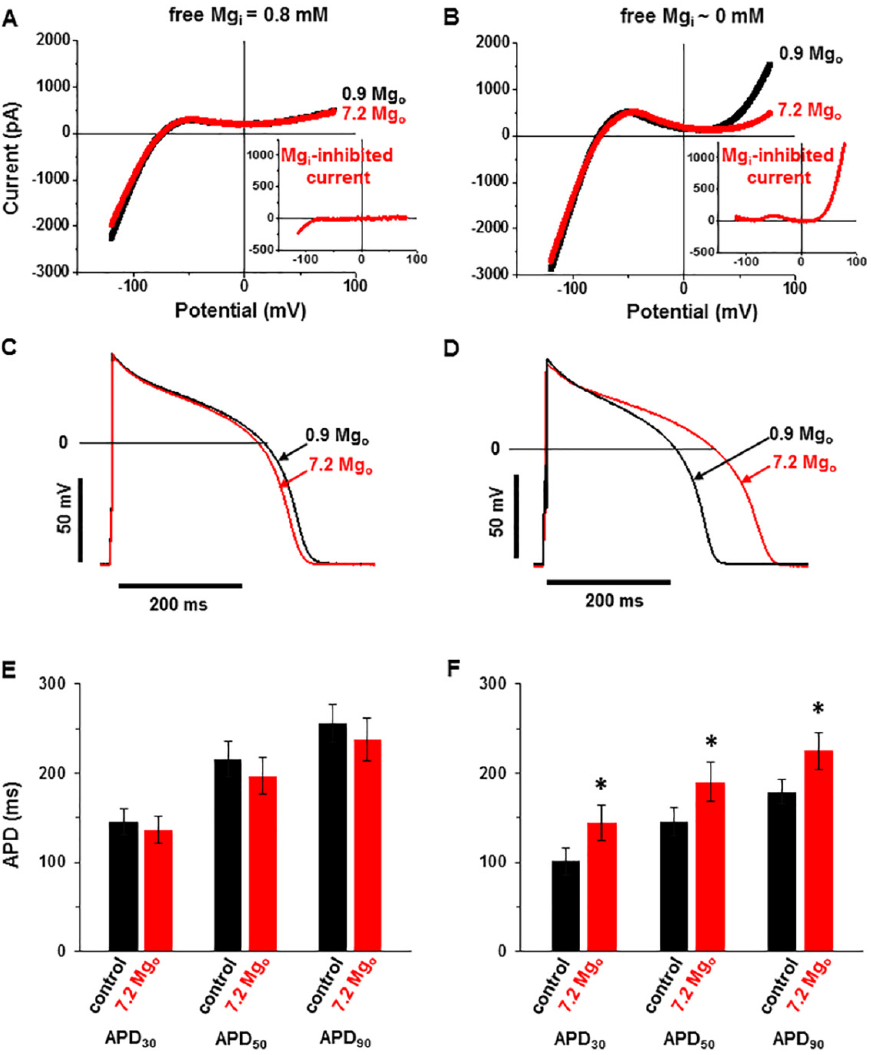
Figure 3. Effect of Mg 2+ -sensitive current activation on the action potential. ( A , B ) Whole-cell currents obtained by voltage ramps in cells dialyzed with 0.8-mM [Mg 2+ ] i ( A ) or 0-mM [Mg 2+ ] i ( B ) and superfused with extracellular solutions containing 0.9-mM [Mg 2+ ] o or 7.2-mM [Mg 2+ ] o . Insets: the [Mg 2+ ] o -sensitive currents calculated as the differences between currents in the presence of 0.9-mM [Mg 2+ ] o and those in 7.2-mM [Mg 2+ ] o . Notice the outward-rectifying [Mg 2+ ] o -sensitive current in the cell dialyzed with 0-mM [Mg 2+ ] i . ( C – F ) The action potentials in the same cells as above, and the summary data of the action potential durations (APD) from all the cells dialyzed with 0.8-mM [Mg 2+ ] ( C , E ) or 0-mM [Mg 2+ ] ( D , F ) and the effect of raising the [Mg 2+ ] o from 0.9 mM (black) to 7.2 mM (red). The APD was measured at 30%, 50%, and 90% repolarization (APD 30 , APD 50 , and APD 90 , respectively). Notice the lengthening of the APD by high [Mg 2+ ] o in the cells dialyzed with low intracellular [Mg 2+ ]. Pacing frequency: 1 Hz. * p < 0.05 for 7.2-mM vs. 0.9-mM [Mg 2+ ] o . n = 9 for the cells dialyzed with 0.8-mM [Mg 2+ ] i ; n = 10 for the cells dialyzed with 0-mM [Mg 2+ ] i